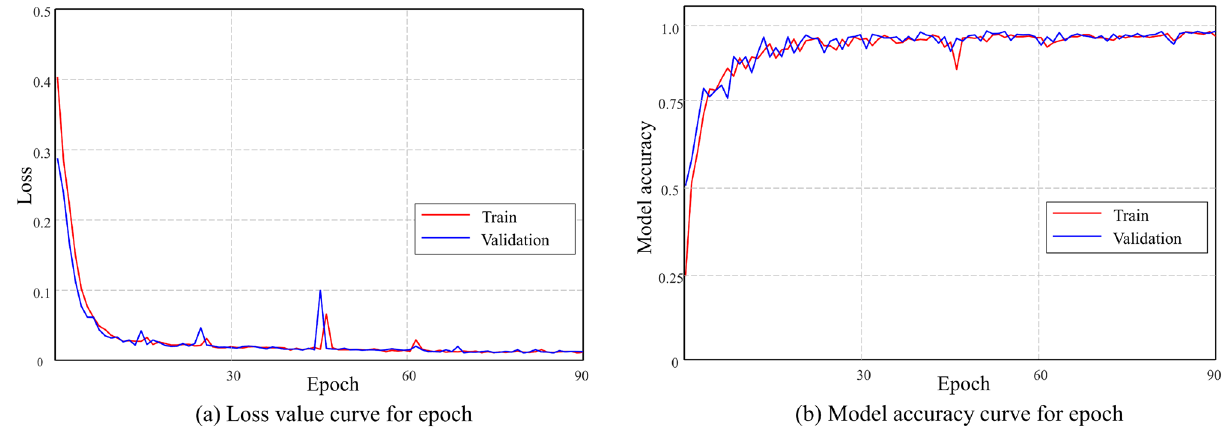
Figure 5. Trained model indicators of voxel size 64 for training and validation